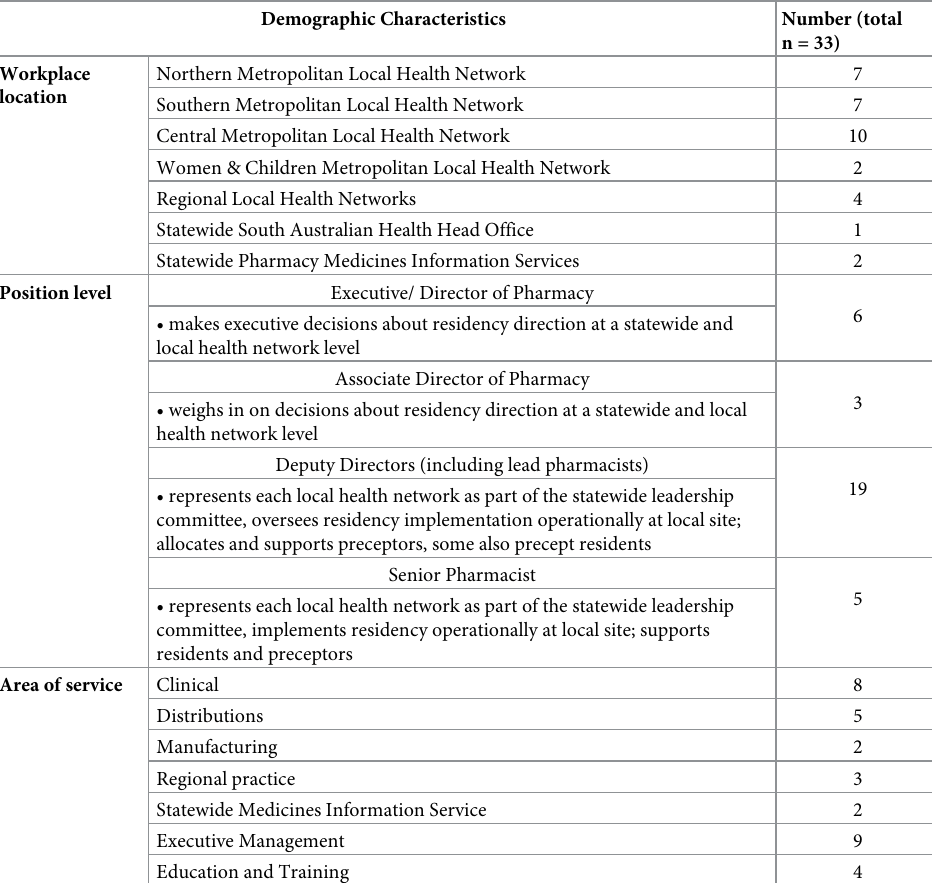
Table 1. Participant demographics.